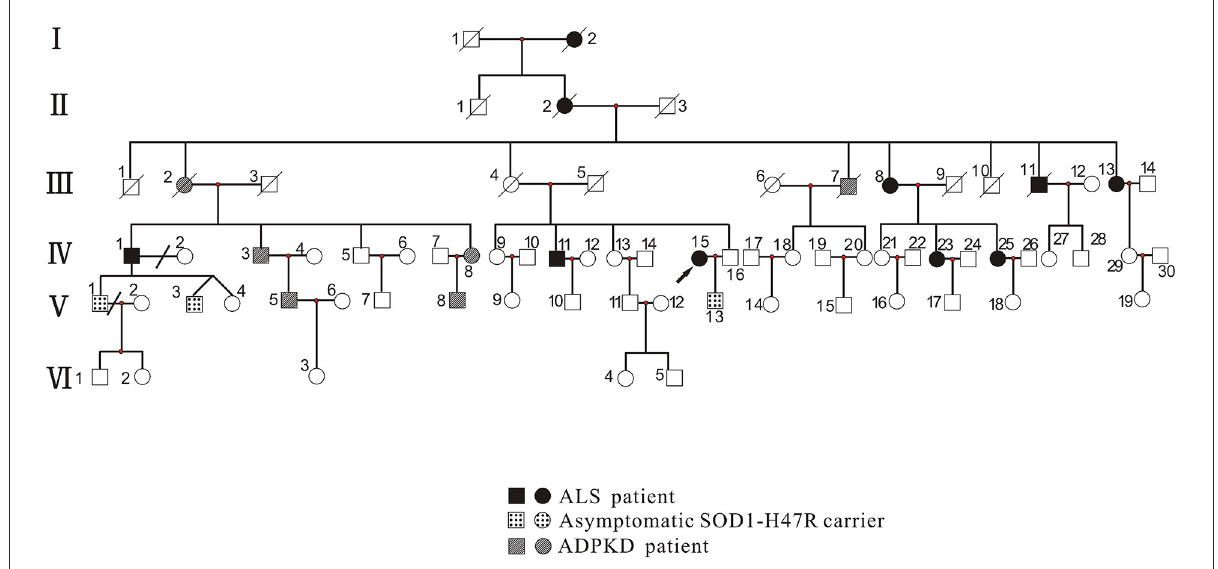
FIGURE1 Pedigree of family with ALS and ADPKD. Patients with ALS included those with the ALS phenotype (III-13, IV-1, IV-11, IV-15, IV-23, and IV-25) who carried the SOD1 p.H47R mutation (note that I-2, II-2, III-8, and III-11 did not undergo genetic testing). Asymptomatic SOD1-H47R carriers were those who had no ALS phenotype but carried the SOD1 p.H47R mutation (V-1, V-3, and V-13). Patients with ADPKD had the ADPKD phenotype (IV-3, IV-8, V-5, and V-8) and carried the PKD1 p.R2787P variant (note that III-2 and III-7 did not undergo genetic testing). Circles indicate women. Squares indicate men. Arrow indicates proband. Diagonal lines indicate deceased individuals.